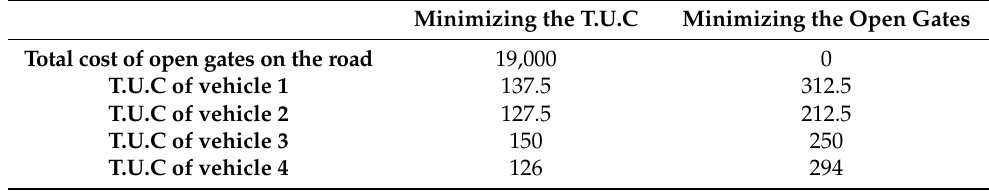
Table 3. Results for each